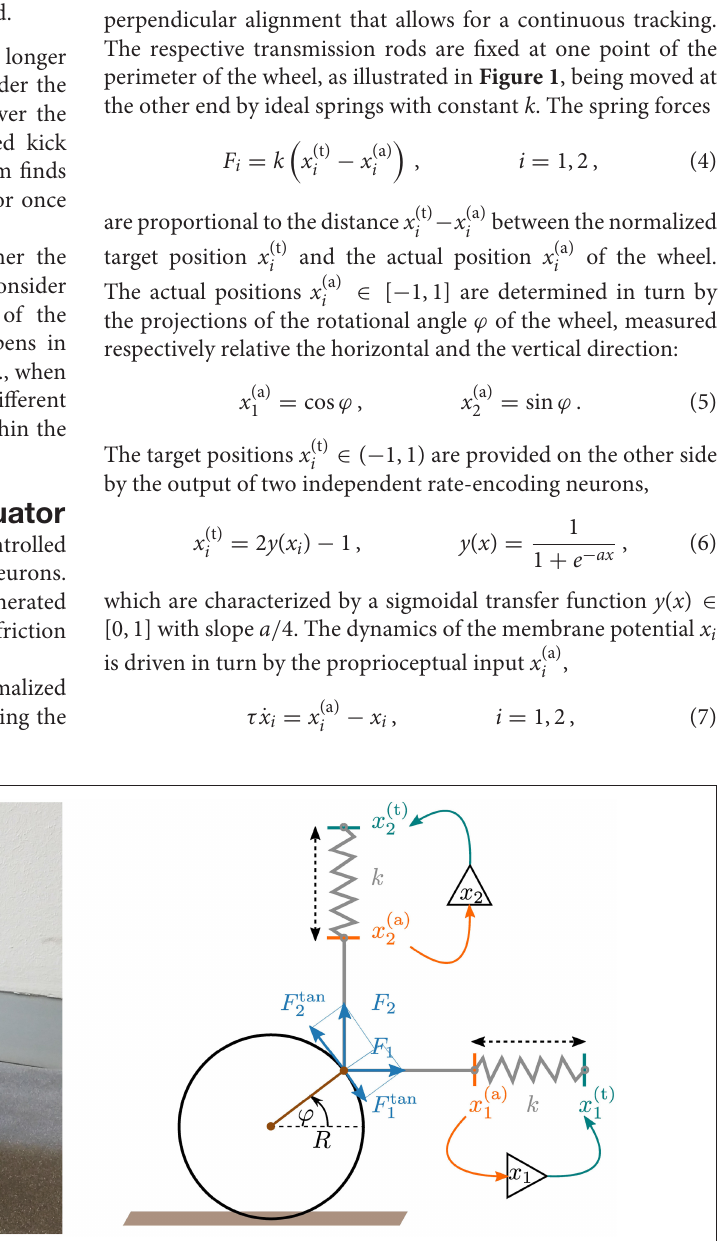
FIGURE 1 | Left : The two-wheeled real robot constructed with the LEGO Mindstorms package. The active wheels are controlled by independent motors. A third passive wheel (the spherical shaped metallic wheel below the robots) keeps the body horizontal. Right : A sketch of a wheel with two perpendicular actuators (click for movie). A spring with spring constant k pulls the rod (in gray) toward the target position x ( t ) i (green). The target position x ( t ) i is determined by the output of a controlling neuron, as described by Equation (6), which receives in turn the actual position x ( a ) i (orange) of the wheel as an input. Compare Equation (5). The final torque acting on the wheel is given by the sum of the tangential components of the spring forces F 1 and F 2 , see Equation (8).